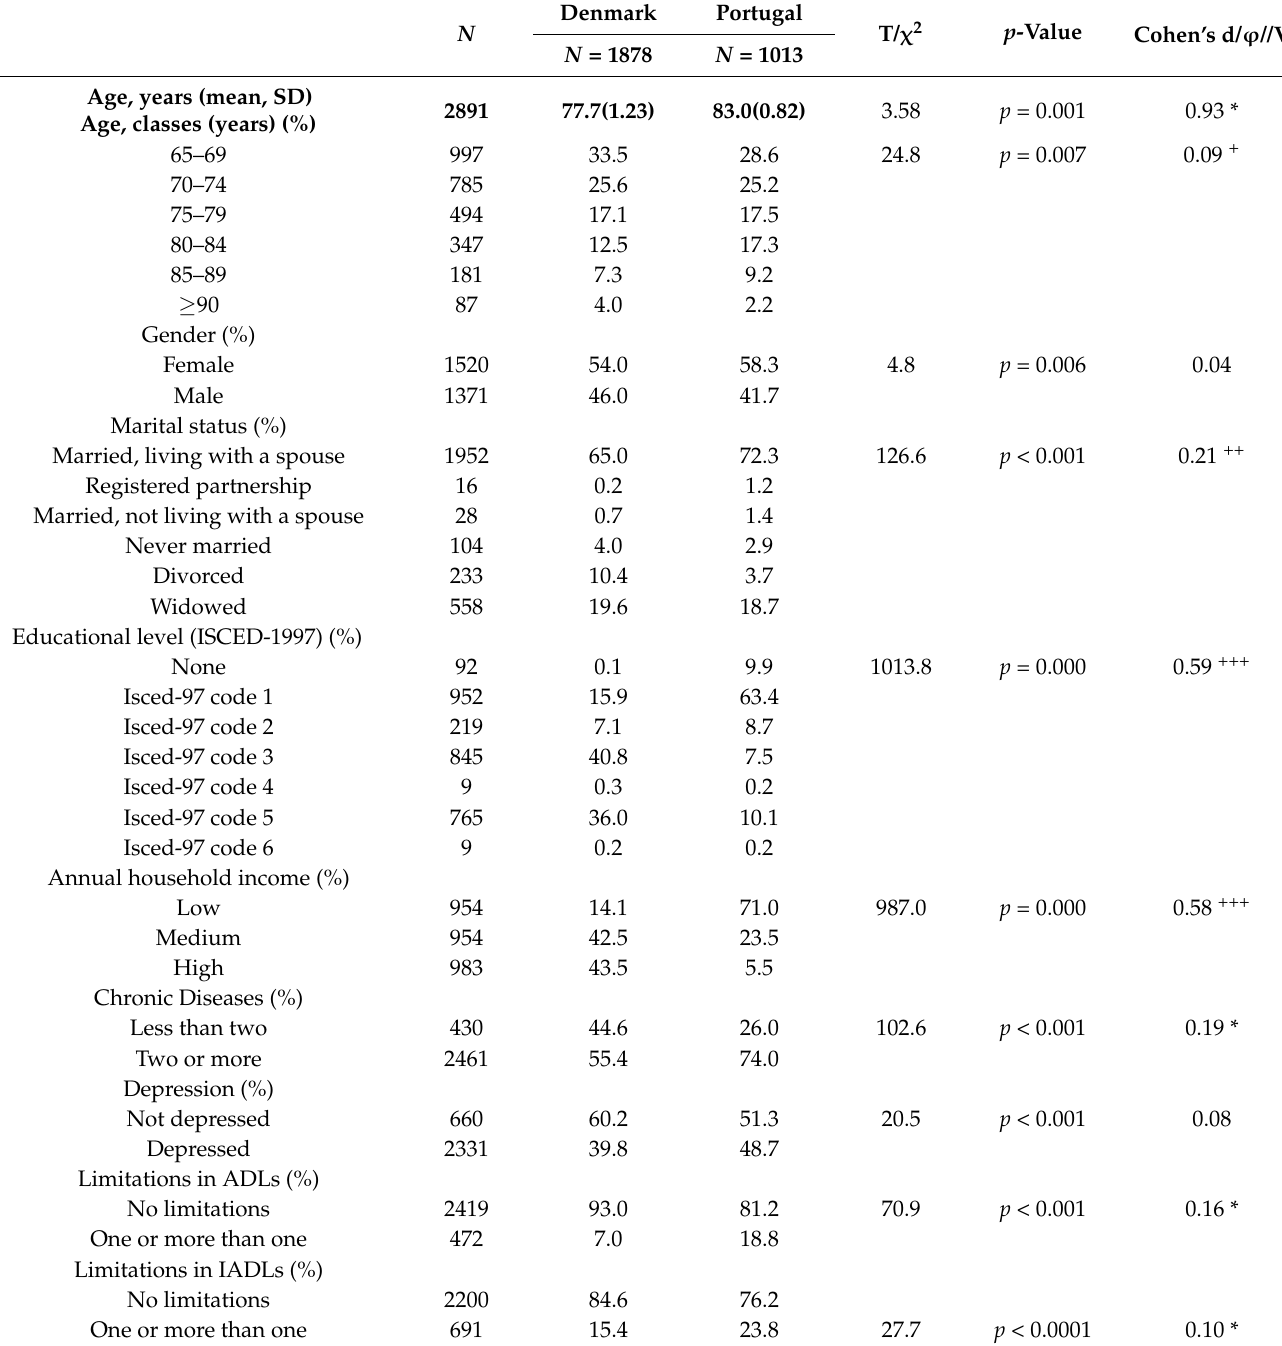
Table 2. Sociodemographic, economic, and health characteristics according to the country. Denmark N